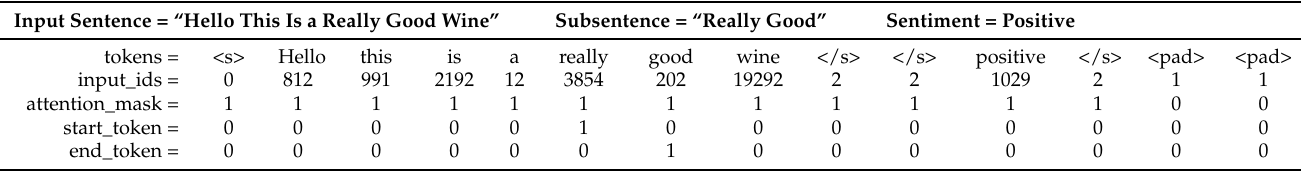
Table 2. An exemplified input data and its